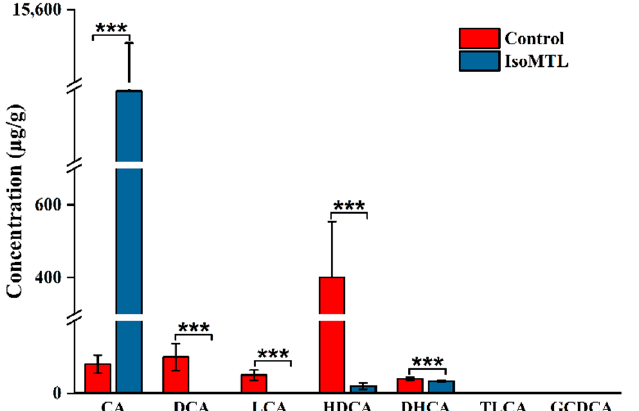
Figure 8. Dietary isomaltulose affects the concentrations of SBAs in fecal samples. CA, DCA, LCA, HDCA, DHCA, TLCA, and GCDCA refer to cholic acid, deoxycholic acid, lithocholic acid, hyodeoxycholic acid, dehydrocholic acid, taurolithocholic acid, and glycochenodeoxycholic acid. * Represents the differences between control and IsoMTL rats (*** p < 0.001).